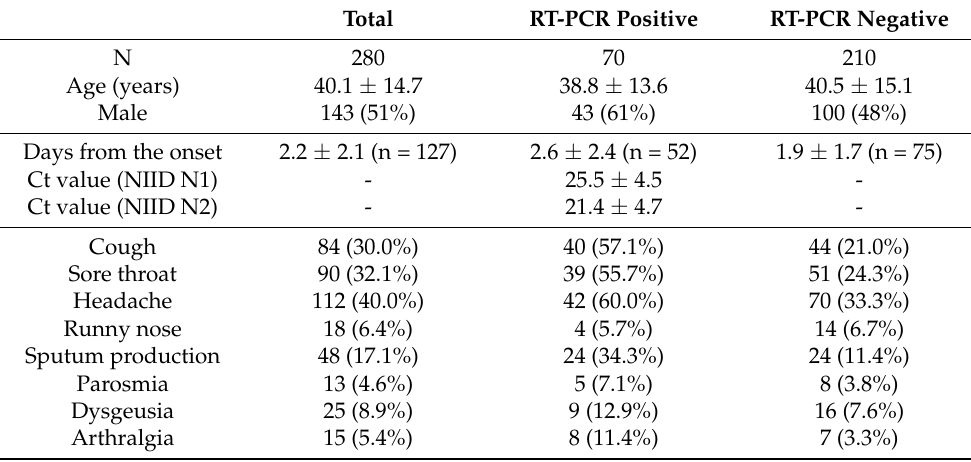
Table 2. Summary of demographical data and symptoms of the study population.